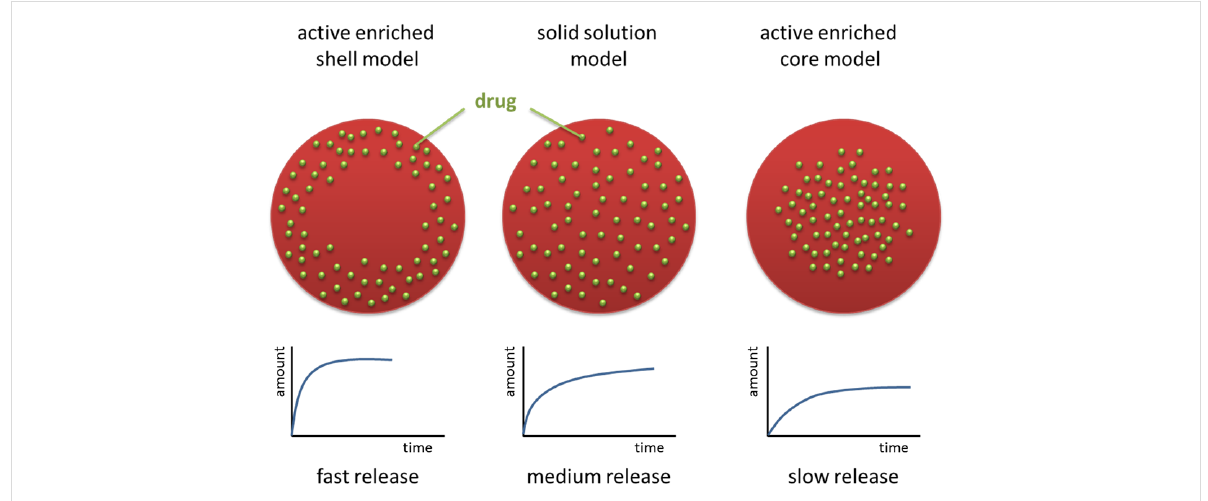
Figure 9: Models of cosmetic active agents or drugs (green) incorporated into lipid nanoparticles, from left to right: enriched shell model (fast release), solid solution model (prolonged release) and enriched core model (very slow release); reproduced with permission from [17], copyright 2017 Elsevier.